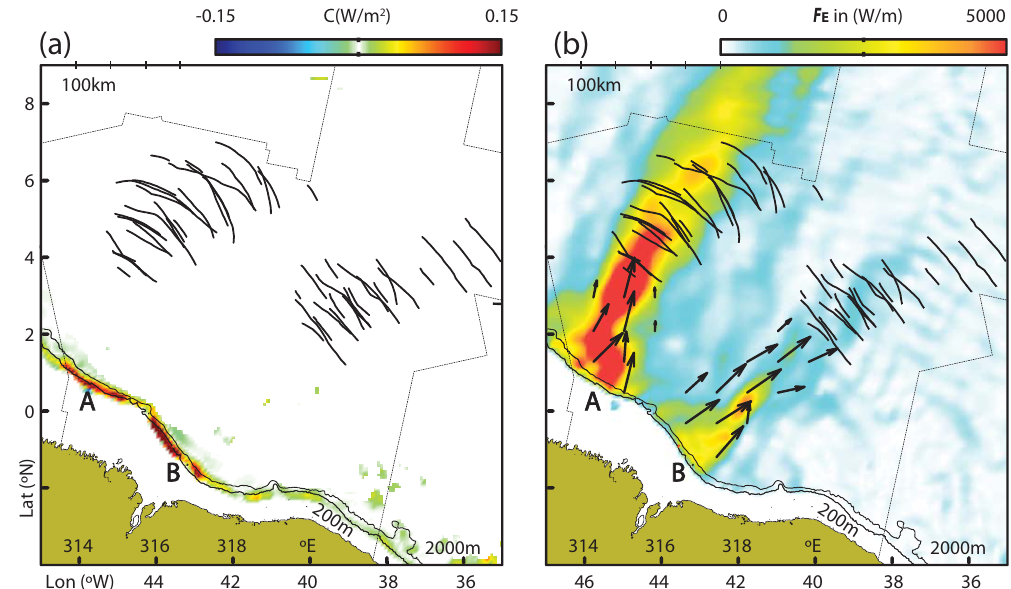
Figure 10. As in Fig. 1 with depth-integrated and time-averaged conversion rates ( C , in left panel) and baroclinic pressure fluxes ( F E , in right panel) for the HYCOM simulations presented in the text (colour scales on top of each panel). Two major IT hotspots are seen in A and B where the surface tide is converted to baroclinic vertical modes, which then propagate in two different pathways to the open ocean.